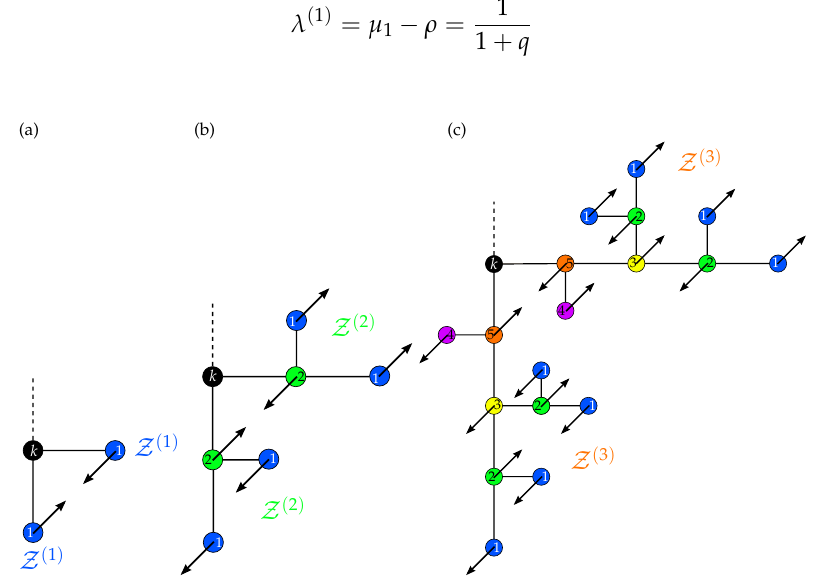
Figure 4. Examples for eigenmodes of the first ( a ), second ( b ) and third ( c ) group. The beads of a branch that move with the same amplitude have the same color. The numbers placed in the beads correspond to the variables used in Equations (12), (14), and (15). The beads k coloured by black x i { } are the gluing beads.